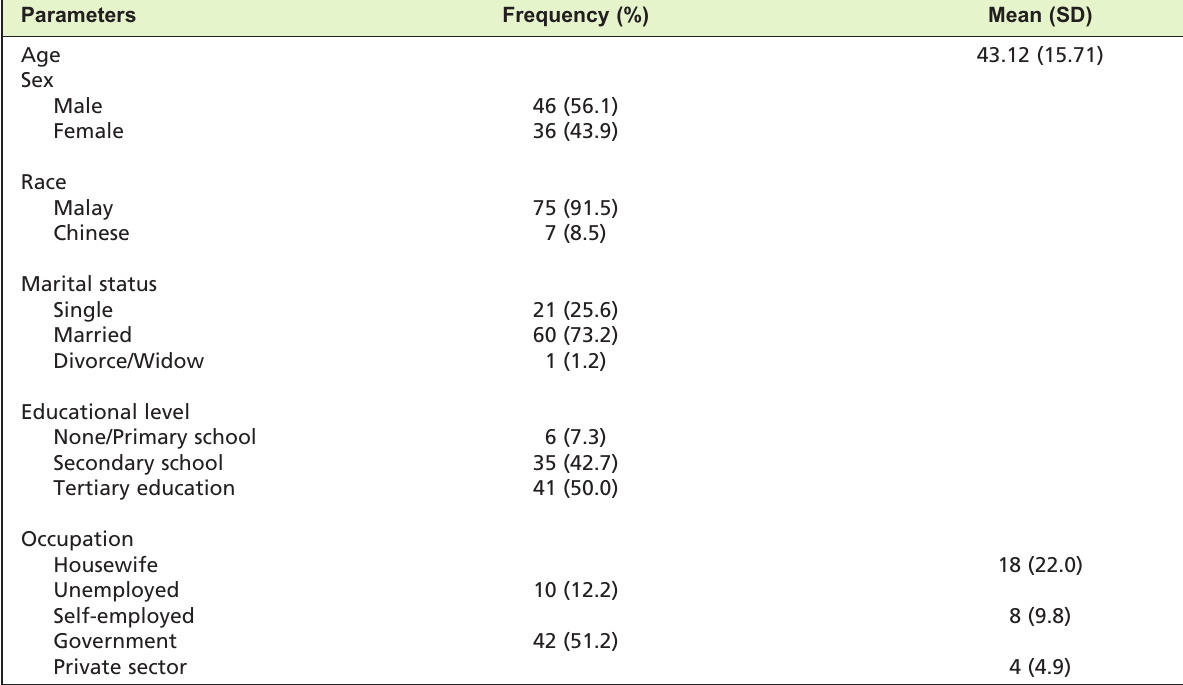
Socio-demographic characteristics of the patients in the Table I: